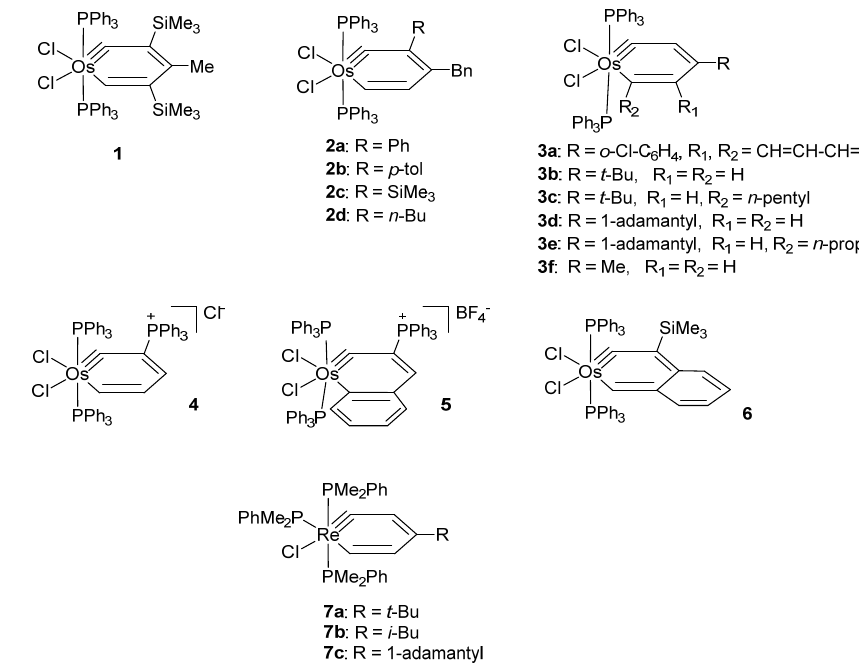
Figure 4. Metallabenzynes reported to date.